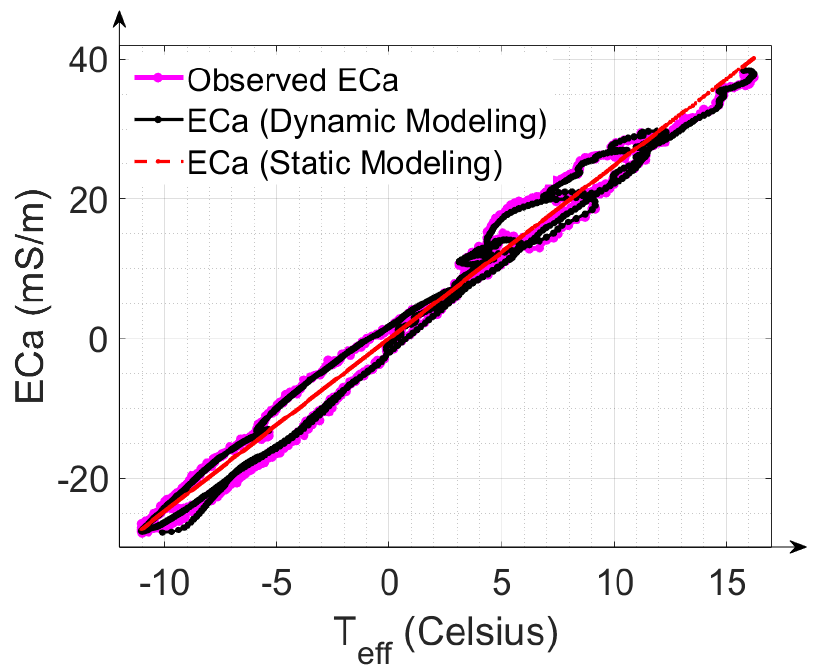
Figure 8. Observed ECa values (pink plot), ECa values generated from dynamic modeling (black plot) and ECa values generated from static modeling (red plot) represented as a function of effective temperature T eff for calibration measurement #16. The ECa values were shifted to have a zero mean to focus on the changes in ECa instead of the absolute values.